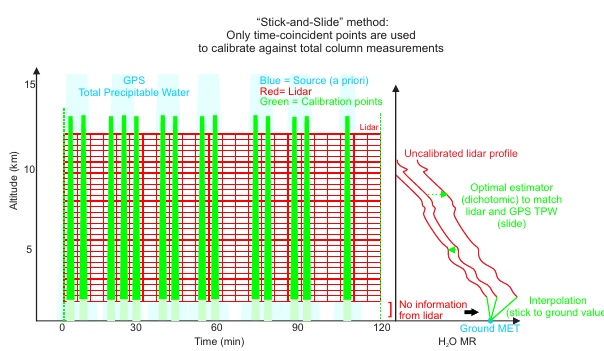
Fig. 16. Schematics of the “stick-and-slide” method used to per- form a calibration of the TMW lidar profiles using co-located and simultaneous GPS Total Precipitable Water measurements. Lidar data points are symbolized by red open rectangles, GPS column data by blue vertical bars, and the actual column data pairs used for the normalization by filled green vertical bars. The sliding un- calibrated lidar profile is shown in red, the constrained water vapor ground-measurement in blue, and the “sticky” interpolated layer in green. See text for